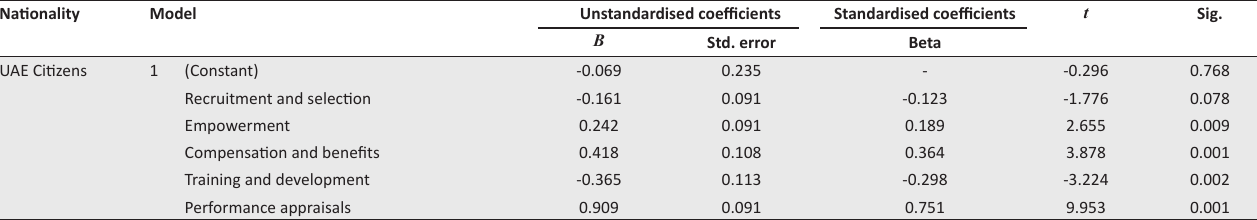
TABLE 5a: Multiple regression results for United Arab Emirates citizens and expatriates. Nationality